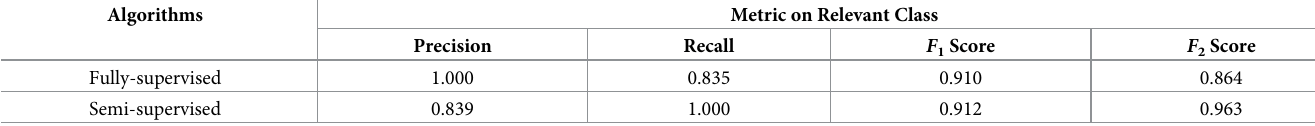
Table 8. Performance results of the best fully-supervised approach and best semi-supervised approach on the minority class—“ relevant .” Algorithms Metric on Relevant Class Recall F 1 Score F 2 Score Fully-supervised